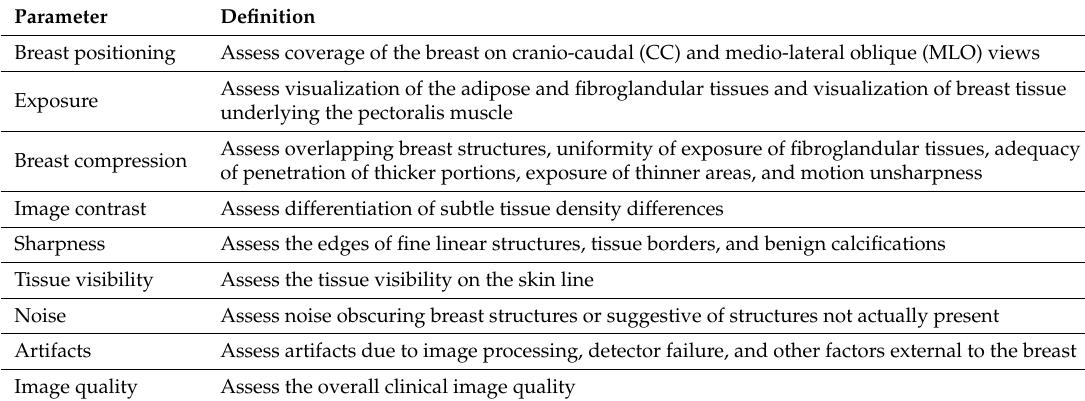
Table 1. Parameters recommended by the Food and Drug Administration (FDA) to judge the quality of full-field digital mammography (FFDM) images [26].